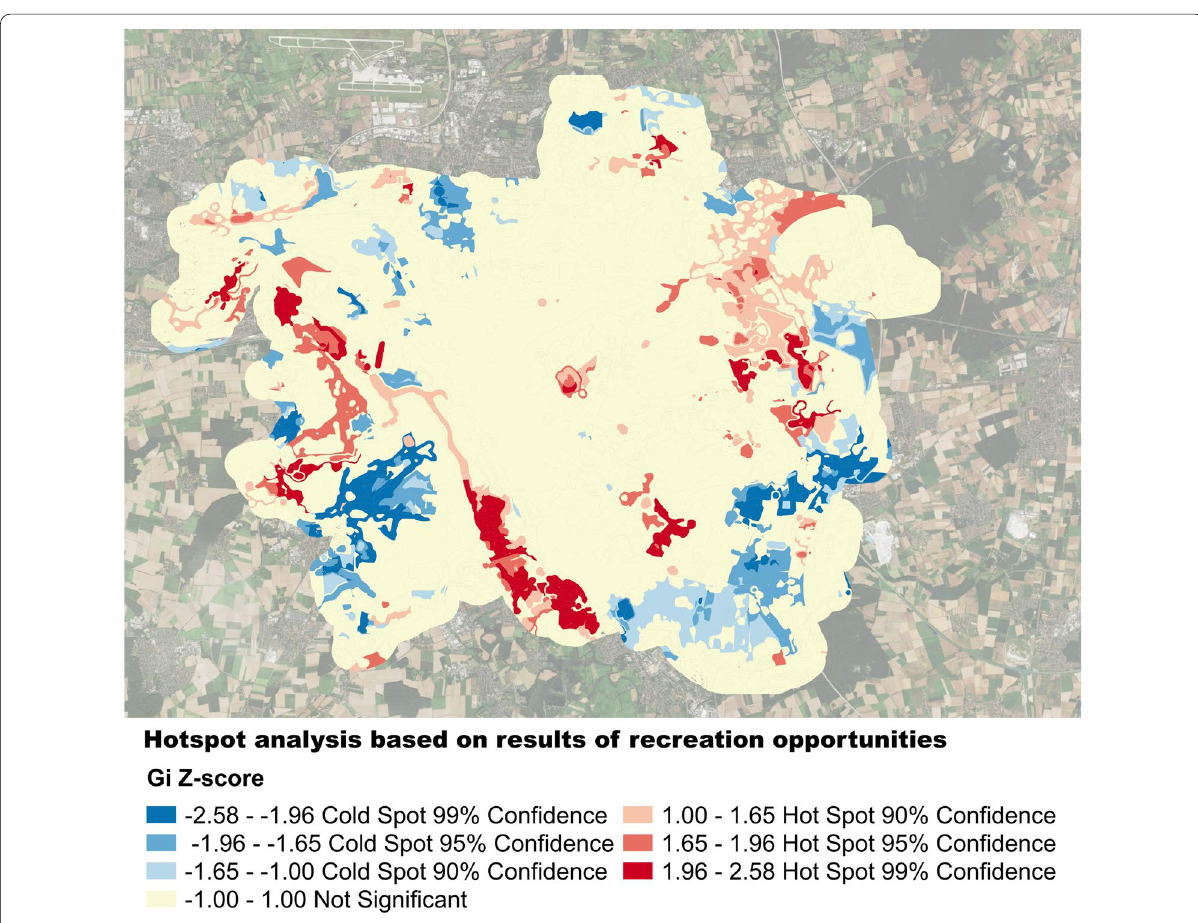
Fig. 8 Hotspot analysis based on the results on NBR opportunities for elderly people. The calculated z -score indicates how many standard deviations the value differs from the